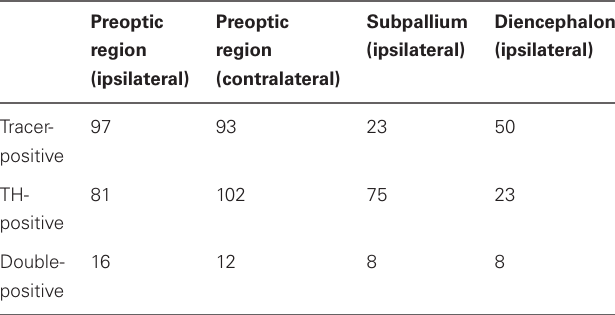
The top rows report the numbers of neuronal somata labeled by tracer injection into Dp and the number of TH-positive neuronal somata in four different brain regions (n = 4 fish). The last row shows the number of double-positive neurons (included in the total counts above). Tracer was applied into Dp on one side of the animal (ipsilateral). Numbers do not reflect the total numbers of neurons in each brain area because only slides containing double-positive neurons were counted. No double-positive neurons were detected in the subpallium or the diencephalon contralateral to the tracer injection